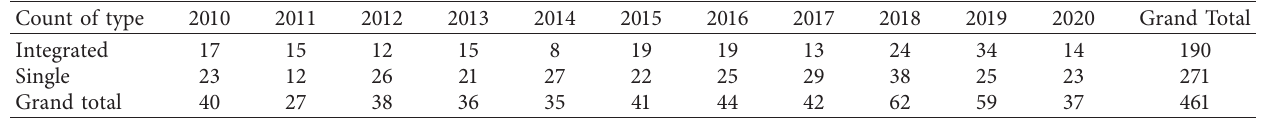
Table 1: Count of type.